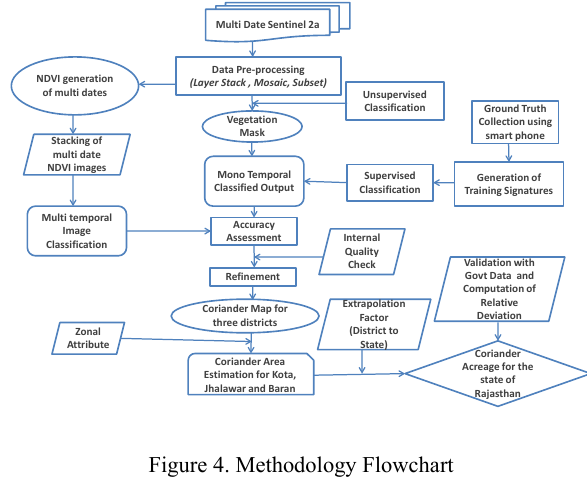
Figure 4. Methodology